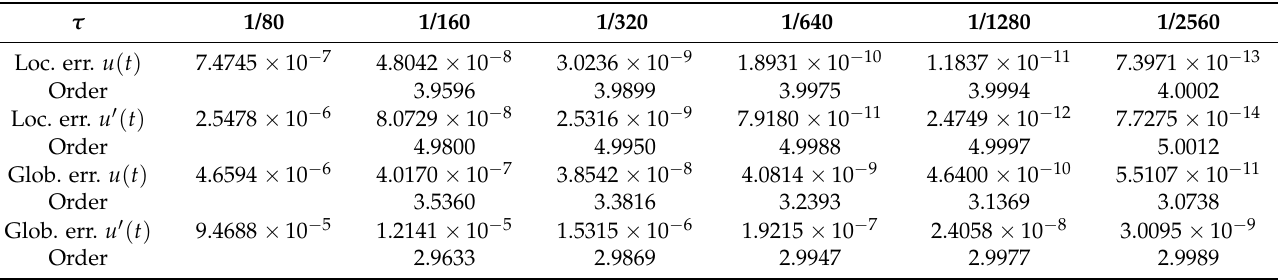
Table 2. Local and global errors and orders for problem (2) with RN3.